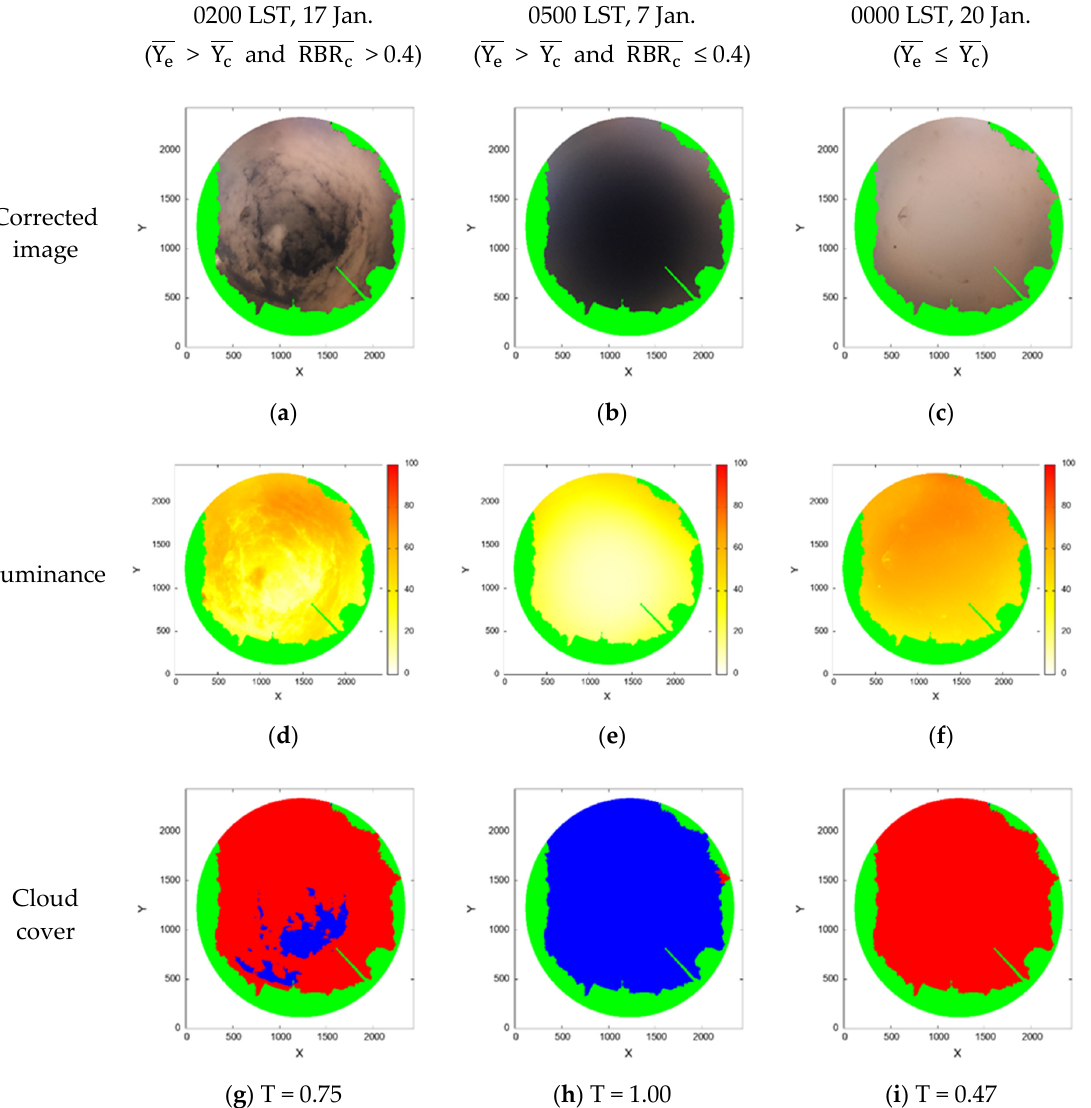
Figure 4. Corrected images ( a )–( c ) and luminance ( d )–( f ) for each nighttime cloud cover calculation algorithm, and cloud cover classification ( g )–( i ) and RBR threshold (T). Green areas represent mask, blue areas the sky, and red areas clouds. The average luminance of the edge (SZA 60–80 ◦ ) and center (SZA 0–20 ◦ ) region is Y e and Y c , respectively. RBR c is the average RBR of the center